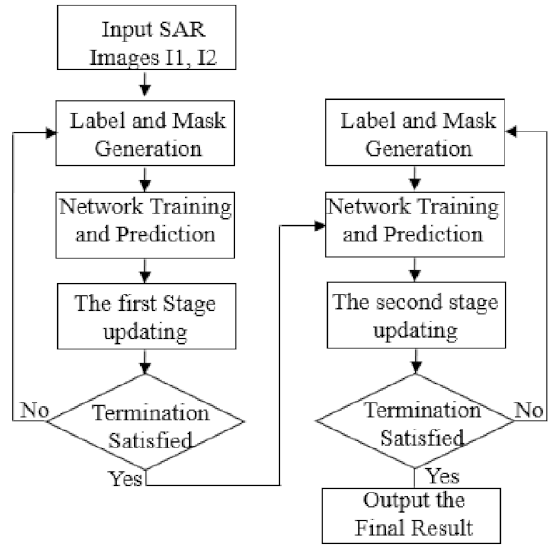
Figure 8. Workflow of the two-stage updating strategy. The input SAR images are first generated to obtain initial label and mask at the pre-classification stage. Then, at the first updating stage, the network, as shown in Figure 6, learns iteratively to restore data diversity gradually. When at the second updating stage, the training process is similar to stage one, except for the updating